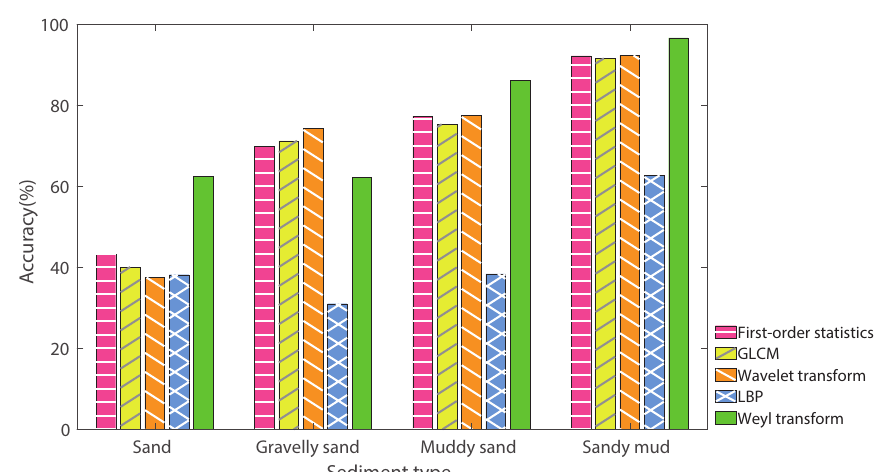
Figure 8. Classification accuracy of the five feature extraction